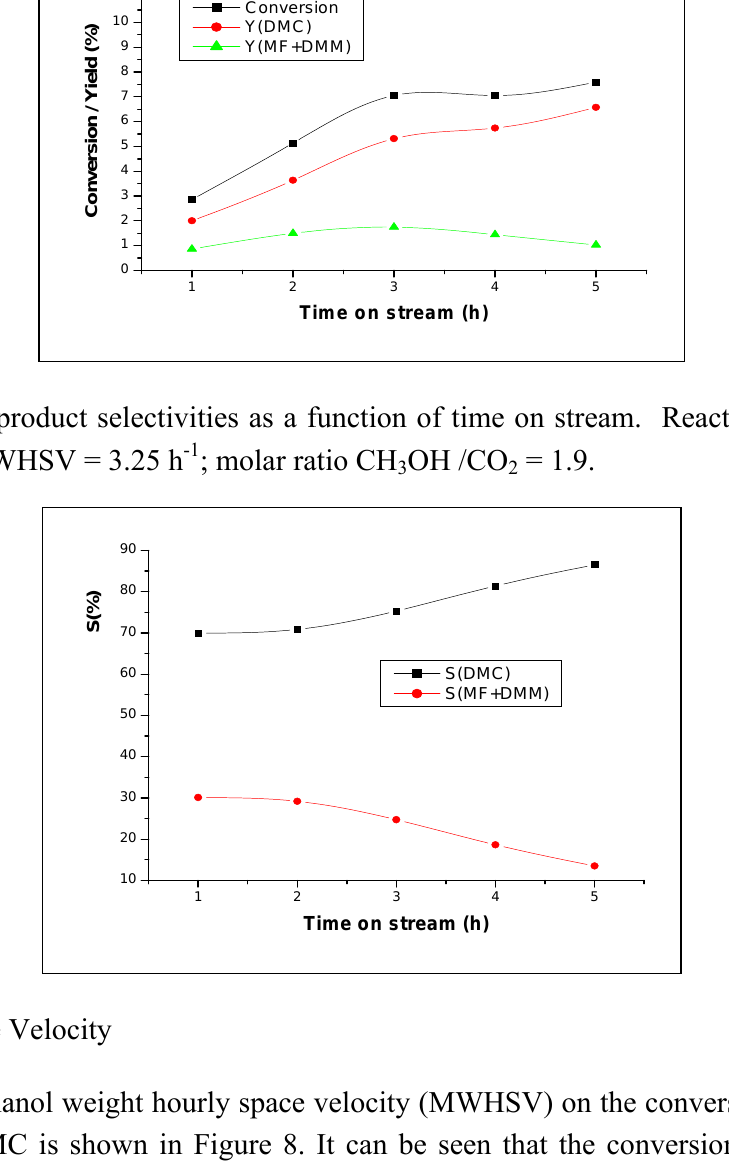
Figure 6. Time on stream effect on the conversion and product yields. Reaction conditions: T = 200 °C; MWHSV = 3.25 h -1 ; molar ratio CH